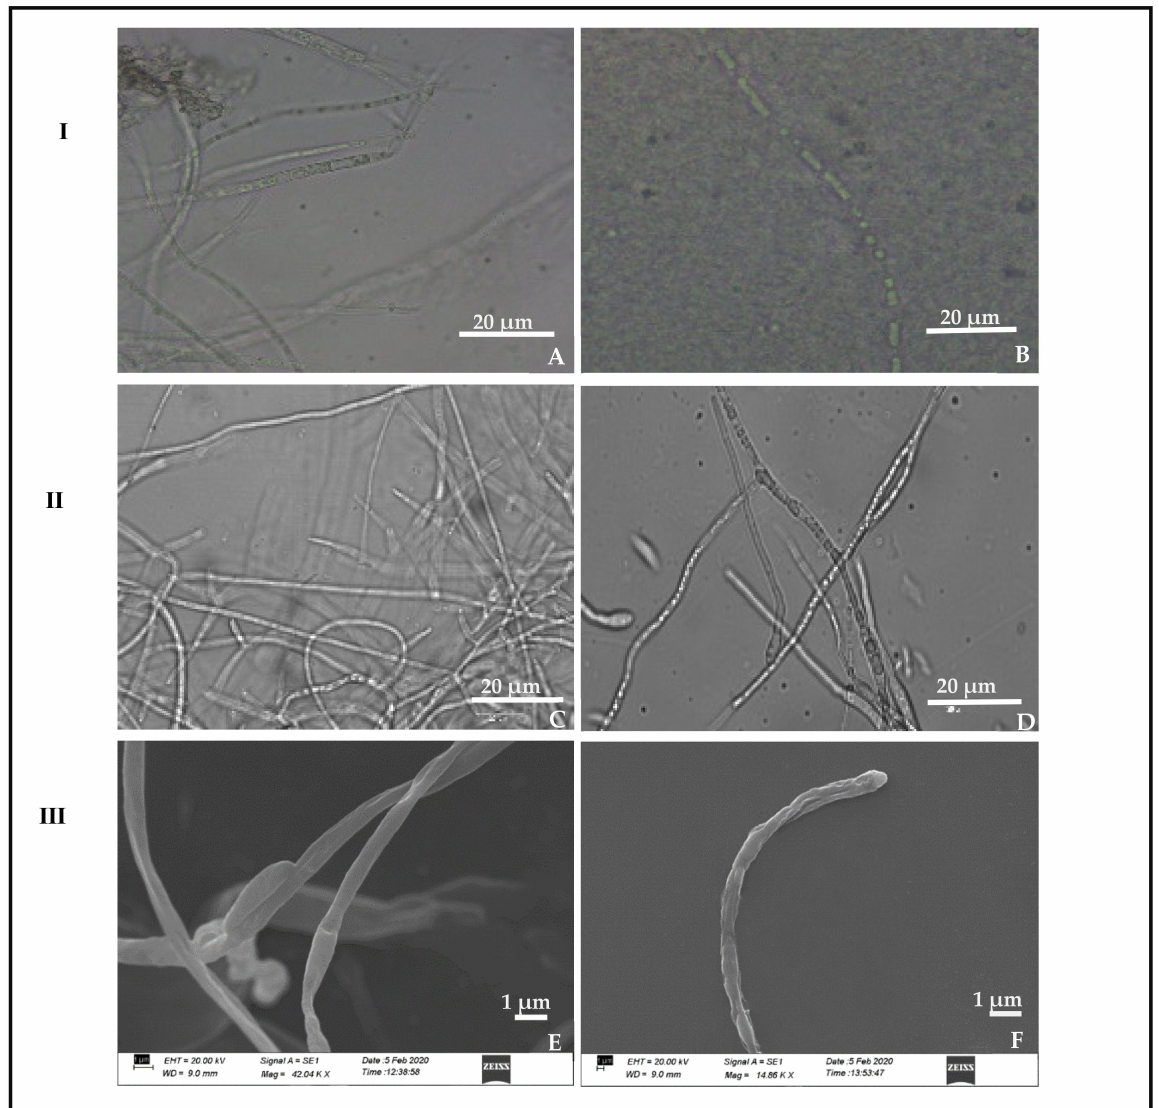
Figure 6. Antagonistic activity of P. dendritiformis in a dual culture plate. ( I ) Light microscope; ( A ) normal hyphae, ( B ) P. dendritiformis in a dual culture plate showing hyphal degradation and lysis. ( II ) Bright field; ( C ) normal hyphae, ( D ) hyphal swelling, disintegration, and leakage of cytoplasmic contents. ( III ) Scanning electron microscope; ( E ) normal hyphae, ( F ) lysis, degradation, and disintegration of